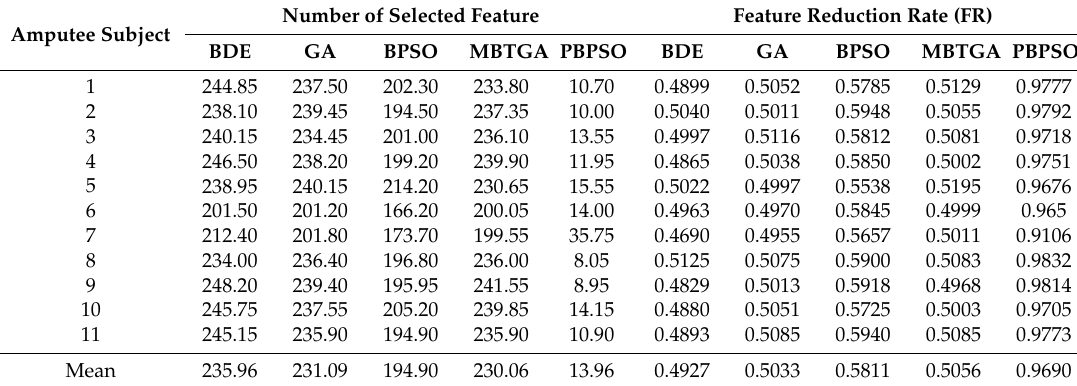
Table 1. Results of feature size and feature reduction rate (FR) of five different feature selection methods for 11 subjects.